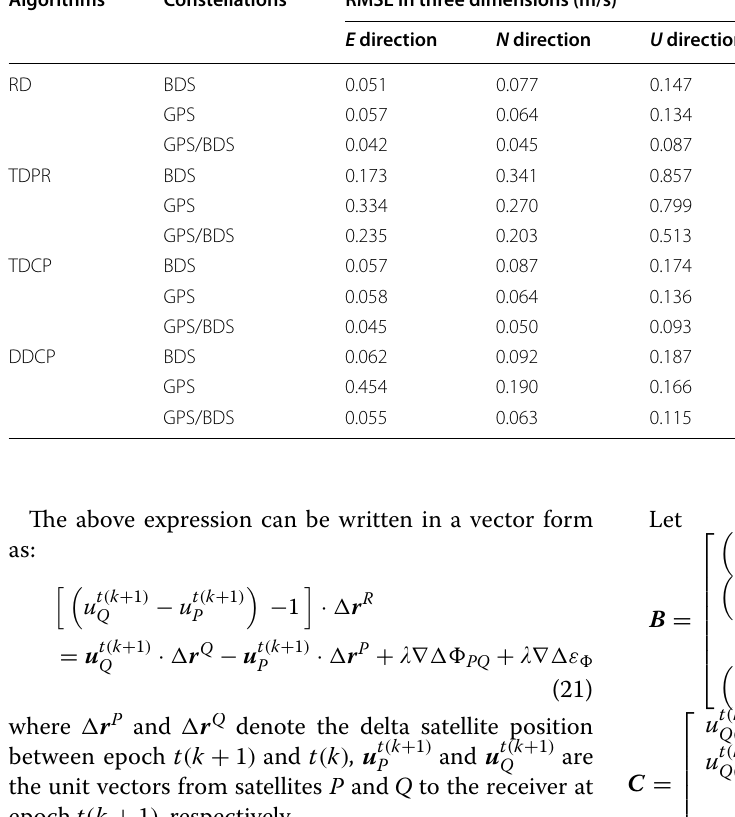
Table 2 A comparison of the obtained velocity accuracies in dynamic test 1 Algorithms